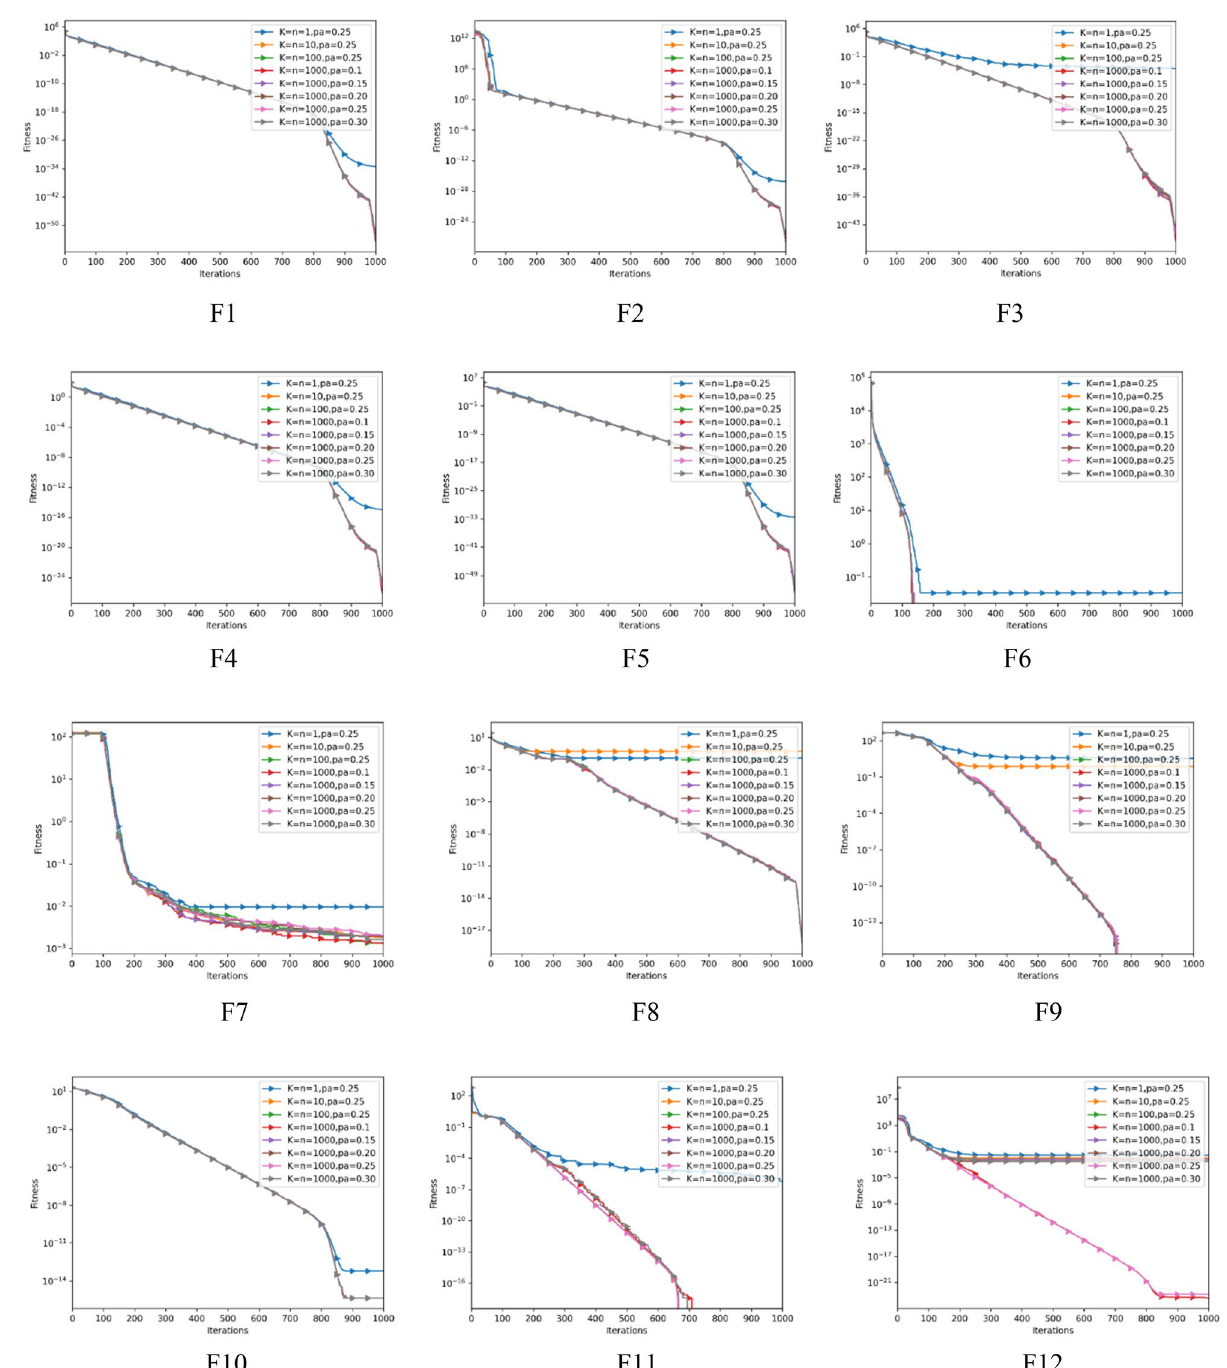
Figure 4. Convergence trajectory values for different parameter